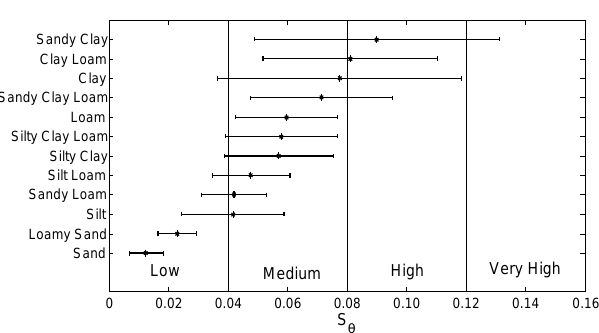
Fig. 7. Average sensitivity index S θ for the 12 USDA soil classes with indication of the standard deviation and the sensitivity classes low (0 ≤ S θ < 0 . 04), medium (0 . 04 ≤ S θ < 0 . 08), high (0 . 08 ≤ S θ < 0 . 12) and very high (0 . 12 ≤ S θ ).